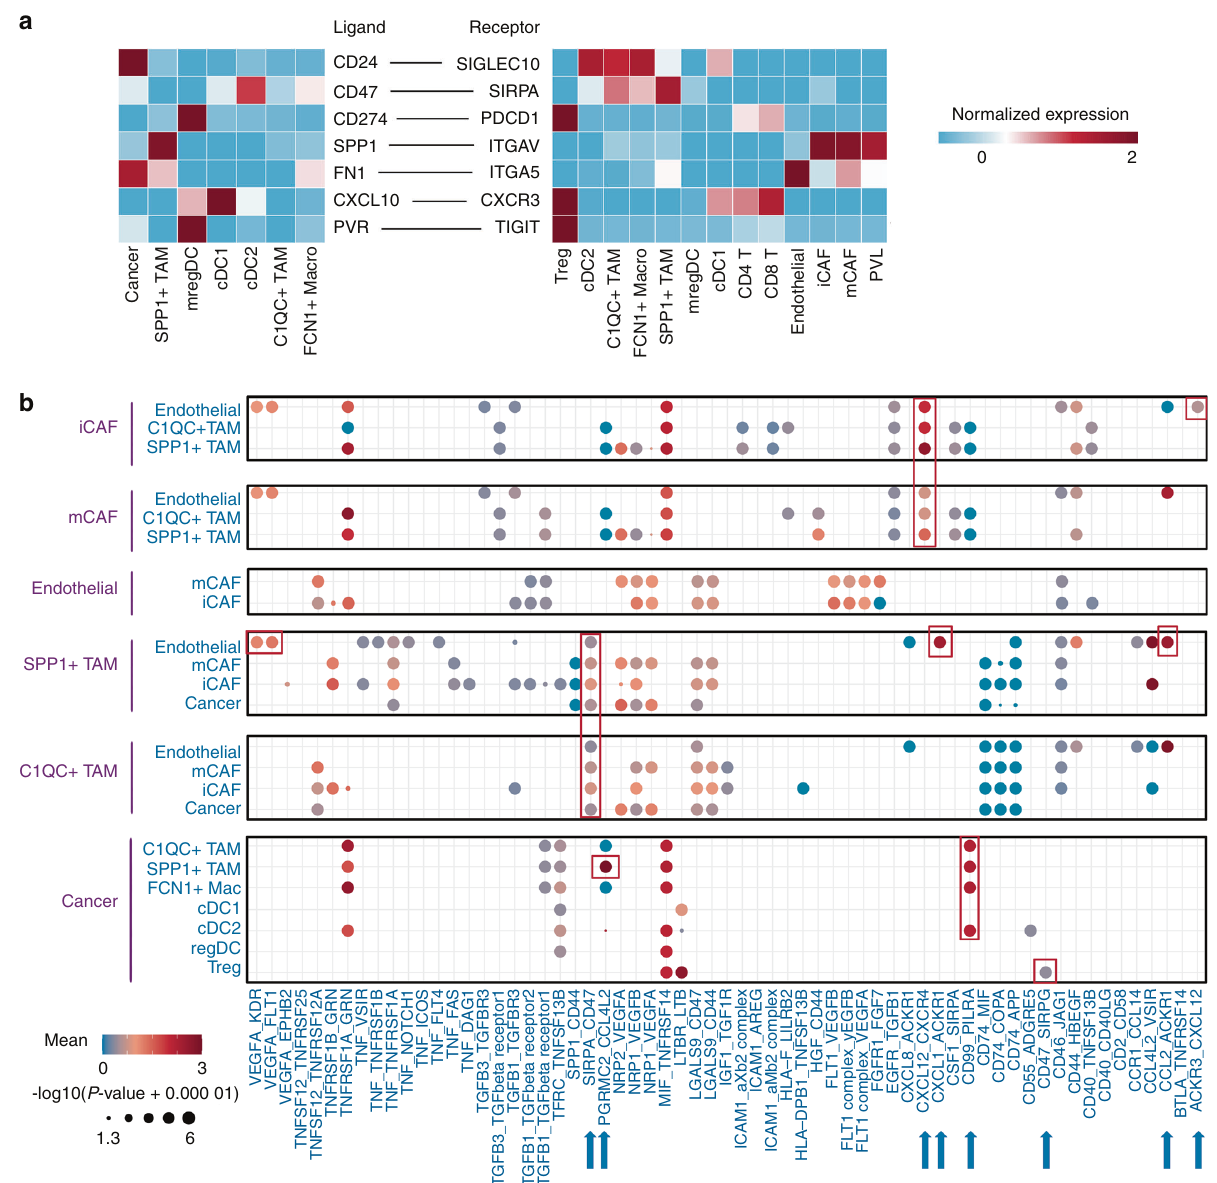
Fig. 7 Predicted cell – cell interaction network in the OS TME. a Heatmap showing the normalized expression of ligands and receptors in the indicated clusters in OS. Red represents high expression; blue represents low expression. b Bubble plots showing ligand ‒ receptor pairs predicted between cell clusters. Dot size indicates the P value generated by CellPhoneDB, colored by mean attraction strength